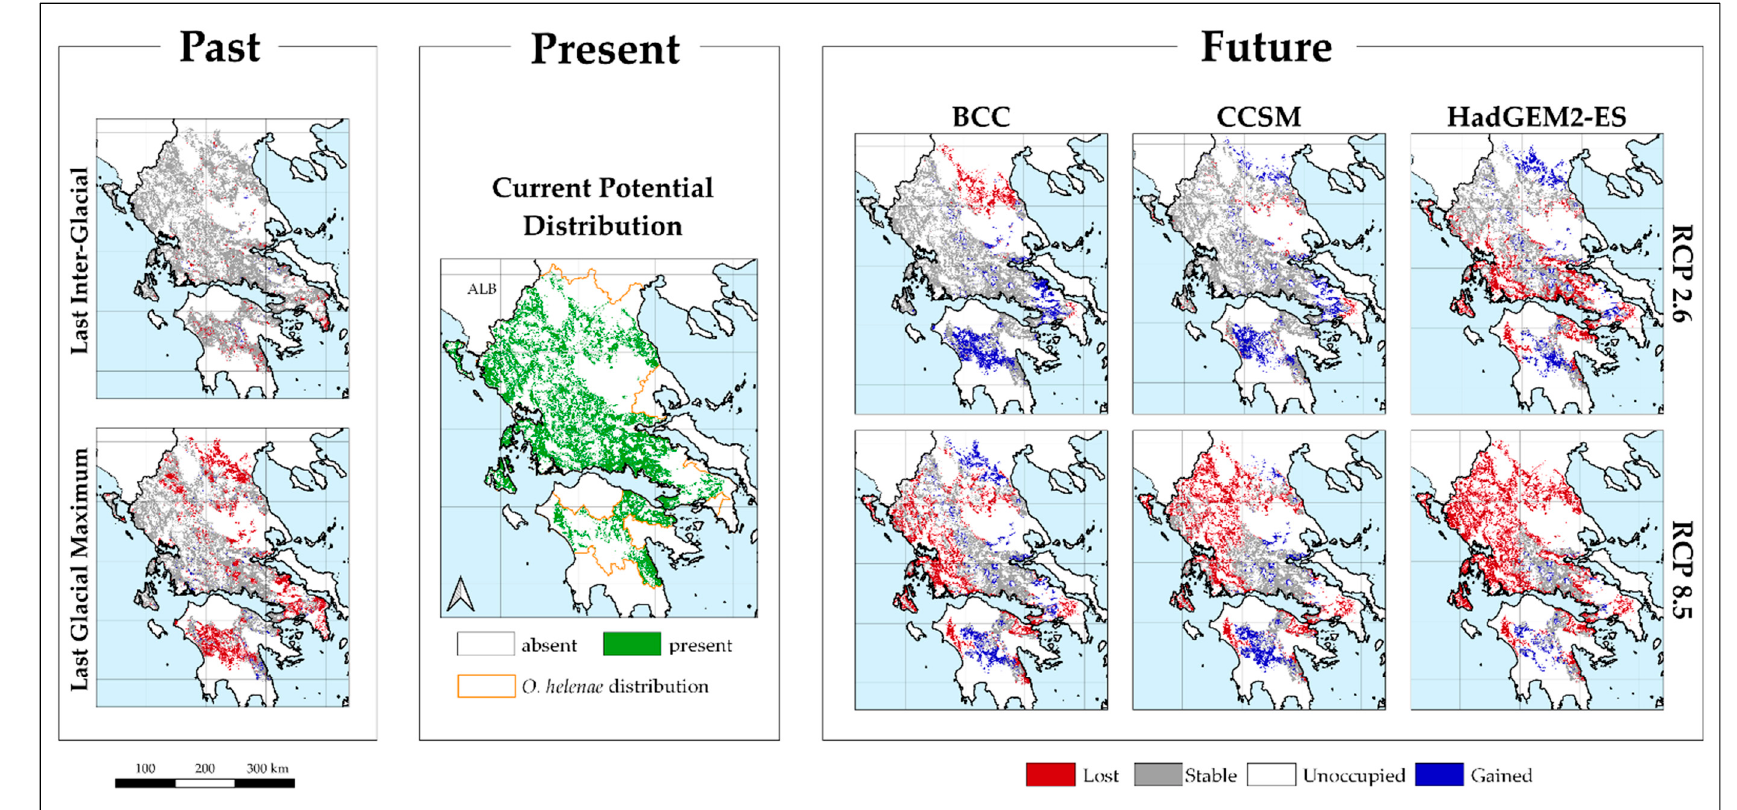
Figure 3. Past, present and future potential distribution maps for Ophrys helenae , based on the geographically thinned occurrence data and climate data from CHELSA (CH GEO ) that show the transition from one time-slice to another. In the central panel, green coloring indicates the cells the species currently potentially occupies, while the orange lines delineate the species’ distributional area. Left-hand panel: past potential distribution maps for showing the transition from the Last Interglacial (ca. 120–140 Kya) to the Last Glacial Maximum Maximum (ca. 20 Kya) and from the Last Glacial Maximum (ca. 20 Kya) to the present time-period. Red, blue and grey coloring depict cells that show loss, gain, or remained stable, respectively, compared to current the previous conditions. Future potential distribution maps represent combinations of three Global Circulation Models (BCC, CCSM4, and HadGEM2-ES) and two Representative Concentration Pathways (RCP 2.6 and RCP 8.5) showing the transition from the present time-period to each respective GCM and RCP combination. The red grid cells in the right-hand panel indicate that the species is currently present at these areas but will not be in the future. The grey grid cells in the right-hand panel indicate that the species is not currently present at these areas and it will not be in the future. The blue grid cells in the right-hand panel indicate that the species currently occupies and will continue to occupy these areas in the